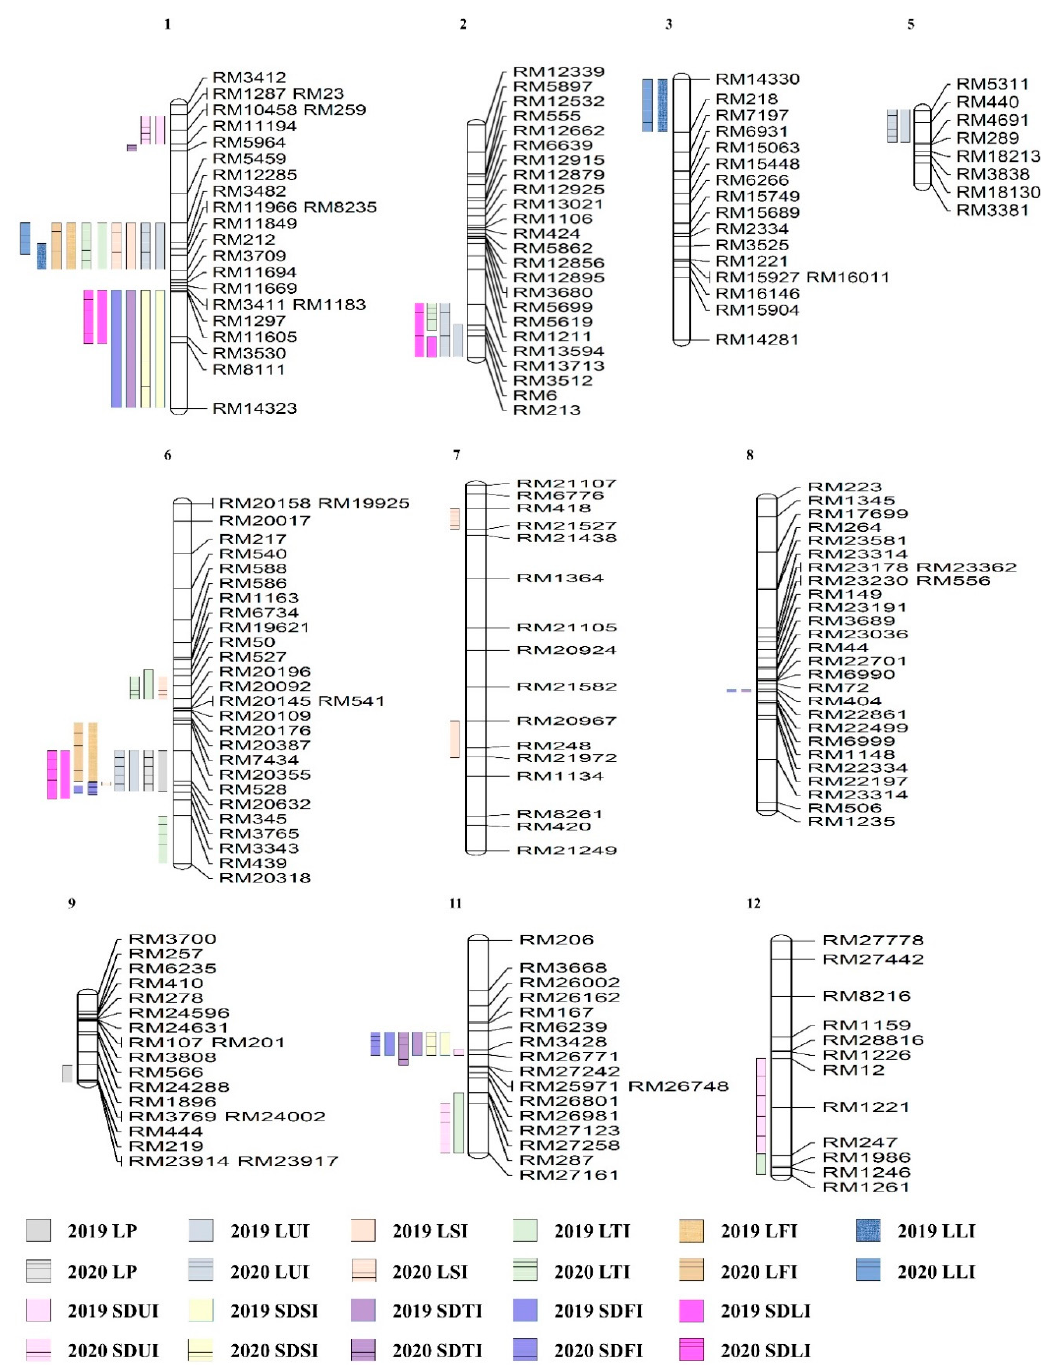
Figure 3. The chromosomal location of QTL is associated with each internode’s length and the stem diameter of each internode in the Cheongcheong/Nagdong doubled haploid (CNDH) population.